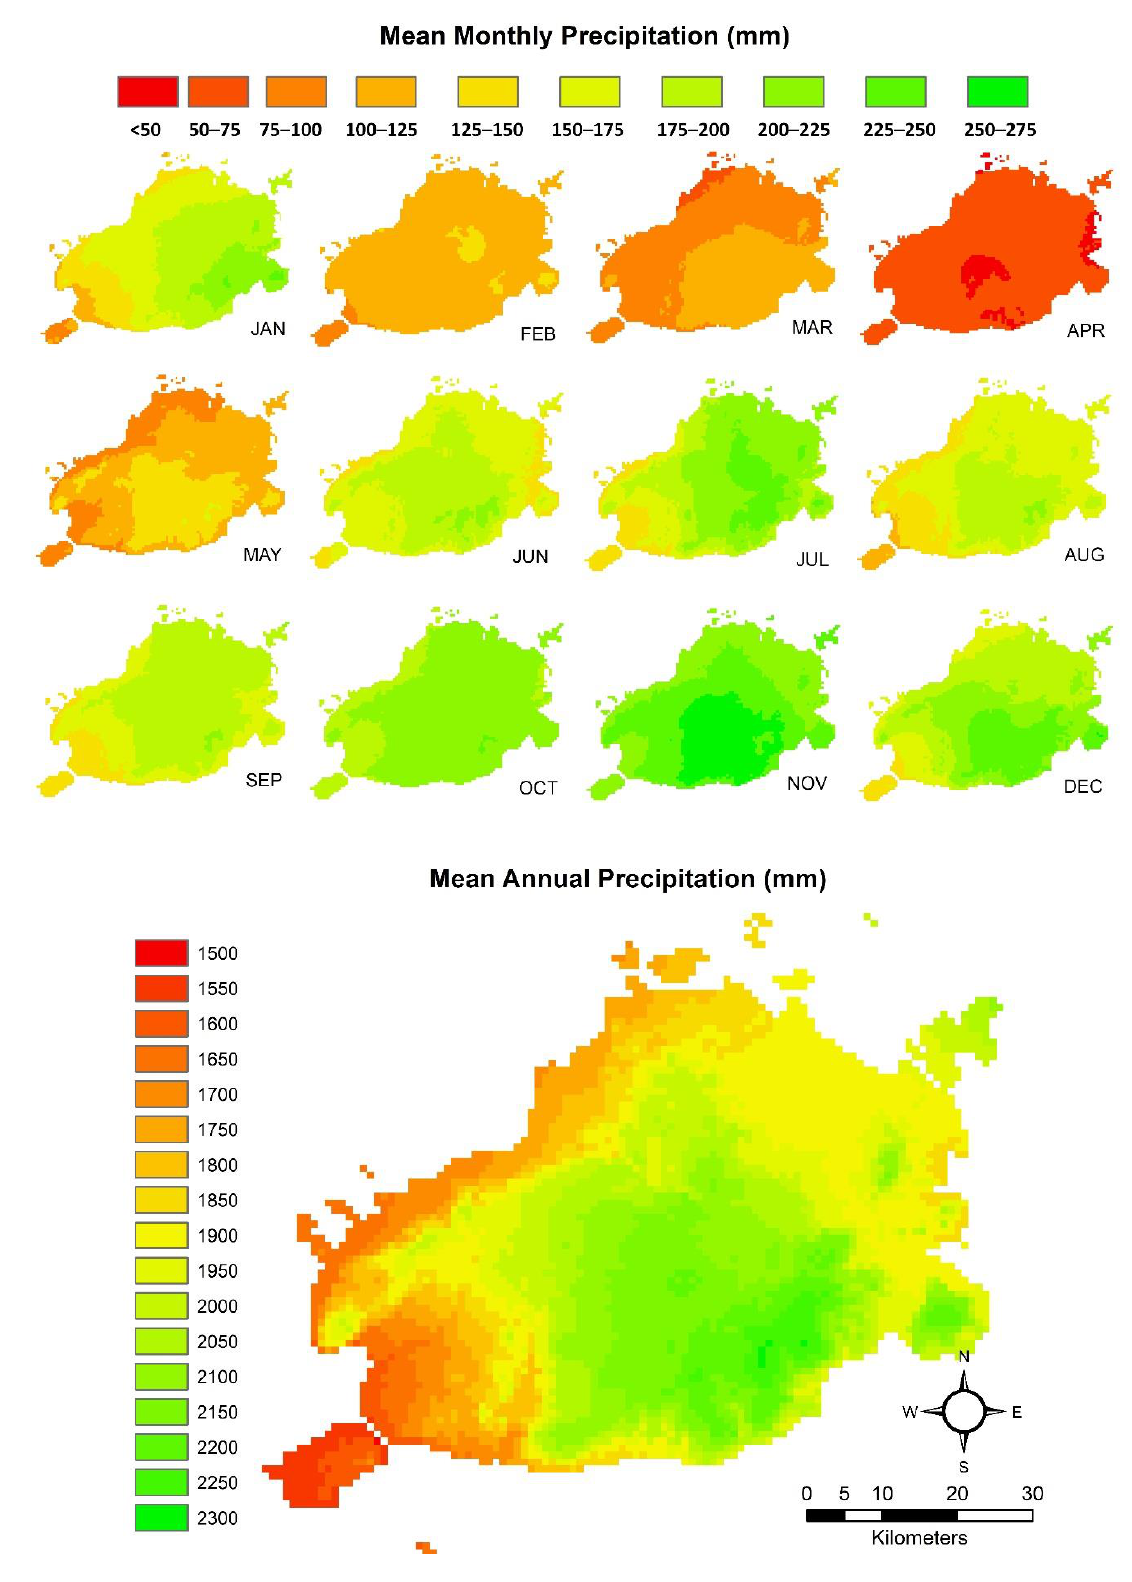
Figure A4. Temporal and spatial variation of precipitation in the study area.